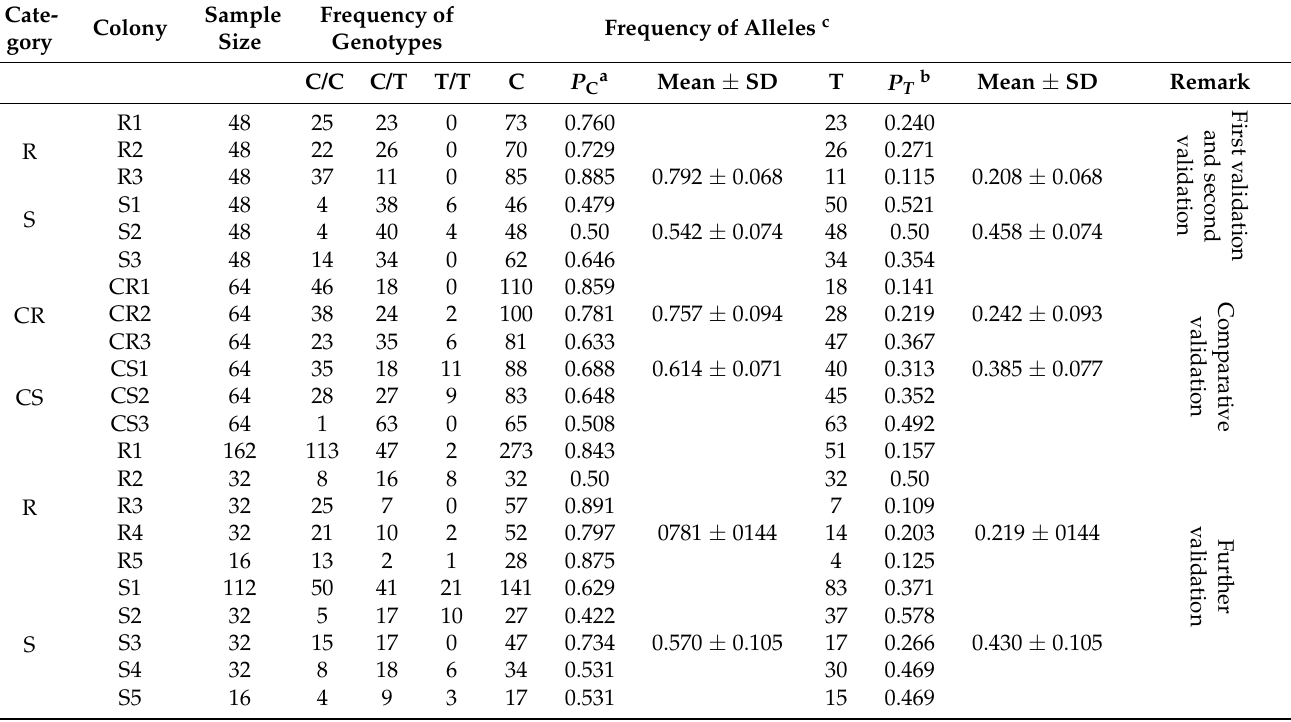
Table 3. Distributions of C and T allele frequencies of SNP